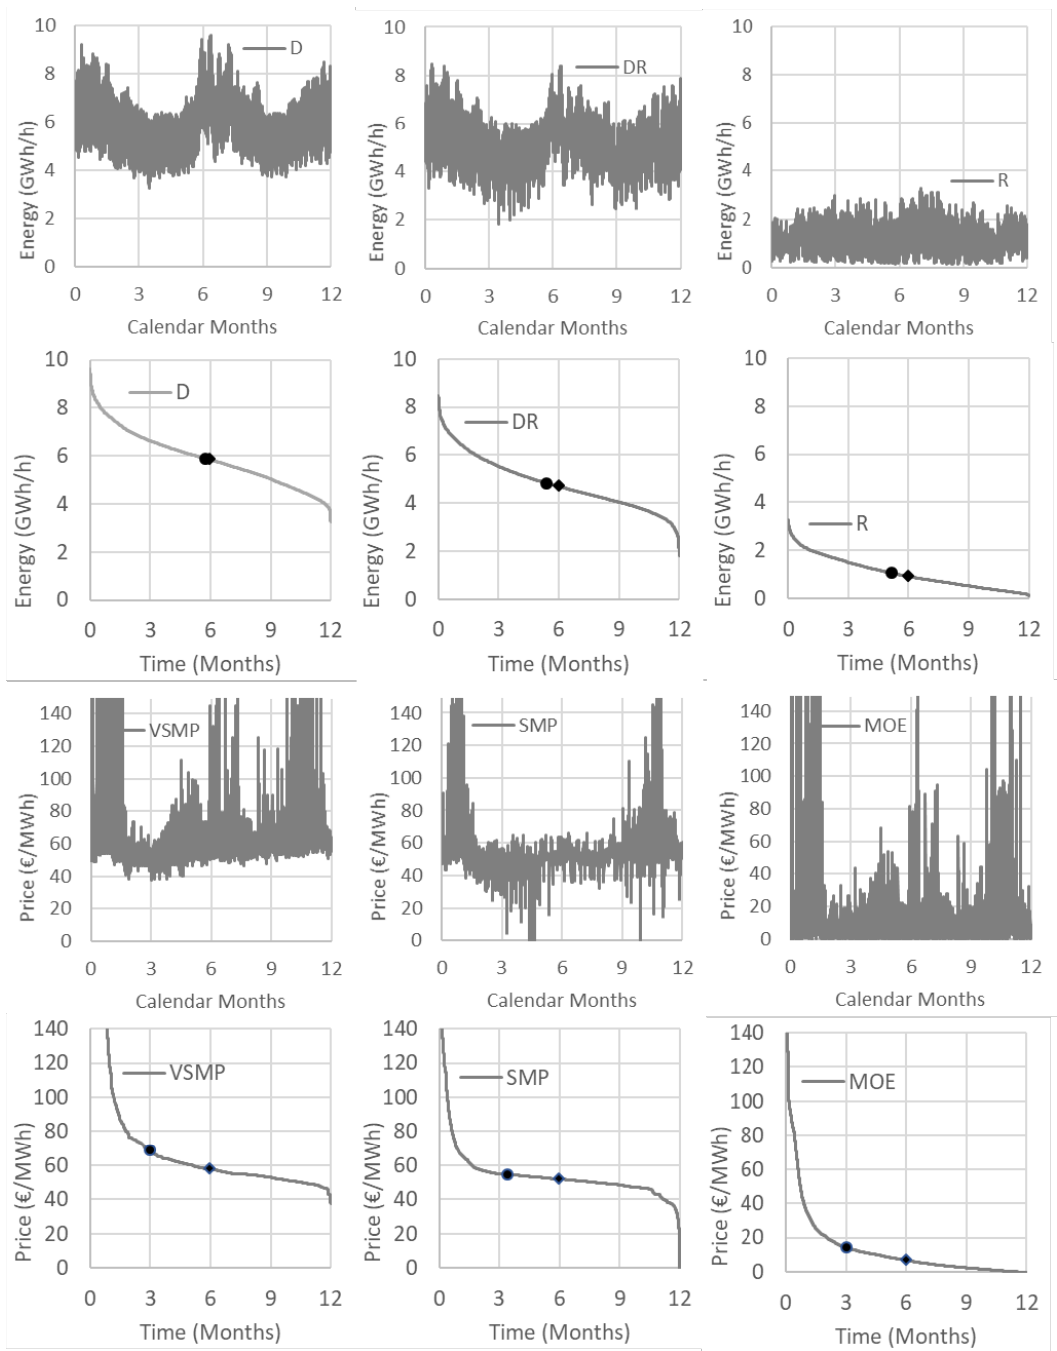
Figure 3. Real data versus time along with the corresponding duration curves: D = demand, DR = demand renewables, R = renewables, VSMP = virtual system marginal price, SMP = system marginal price, MOE = merit order effect. Data from Hellenic electricity market operator [33] and the Hellenic energy exchange group [34].